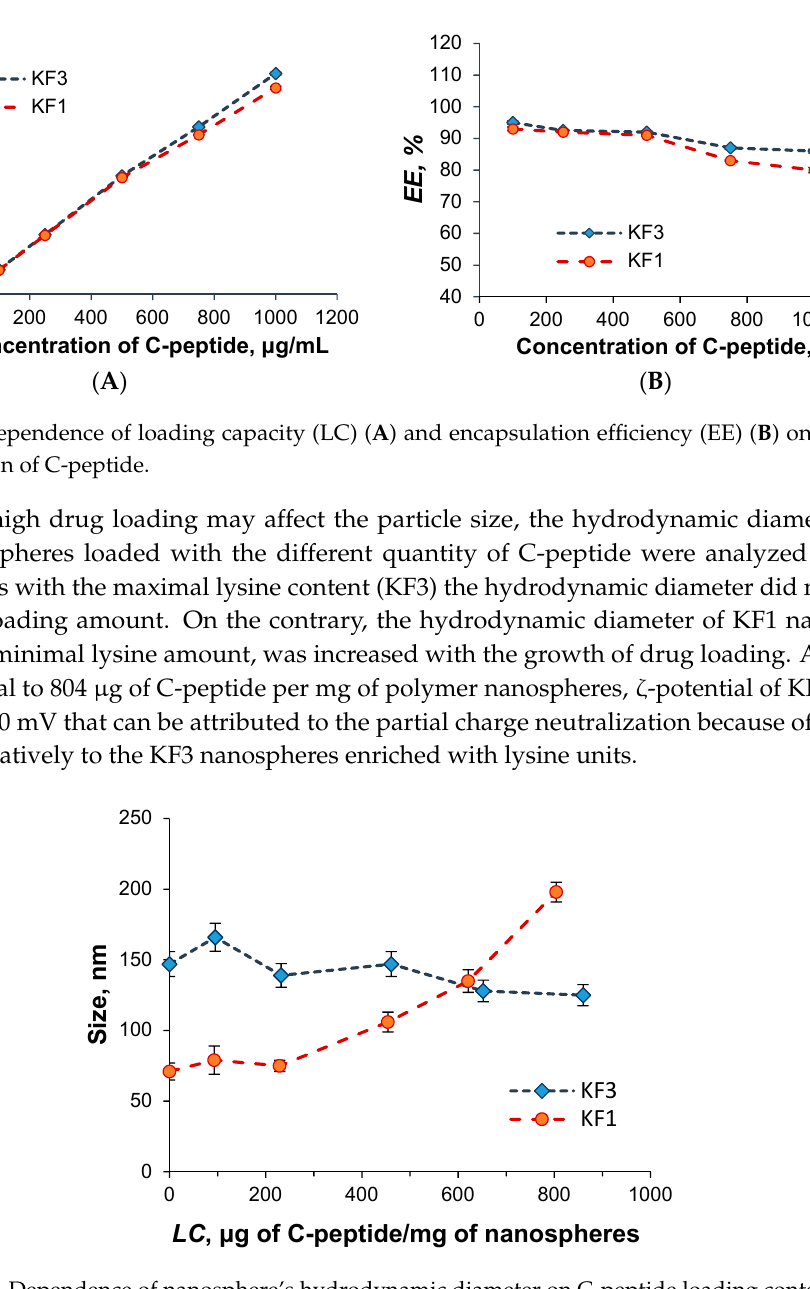
Figure 8. Dependence of nanosphere’s hydrodynamic diameter on C-peptide loading content.